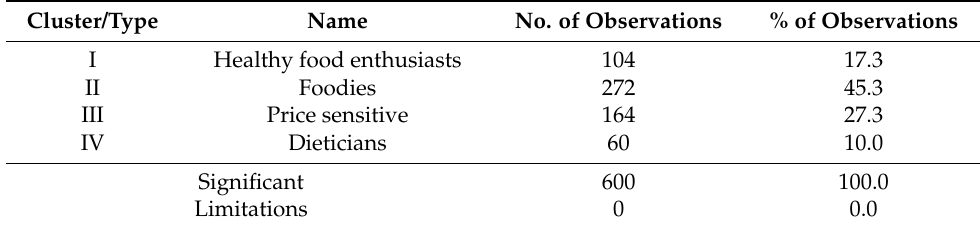
Table 3. Types of Polish consumers by consumed food products and non-alcoholic beverages. Cluster/Type